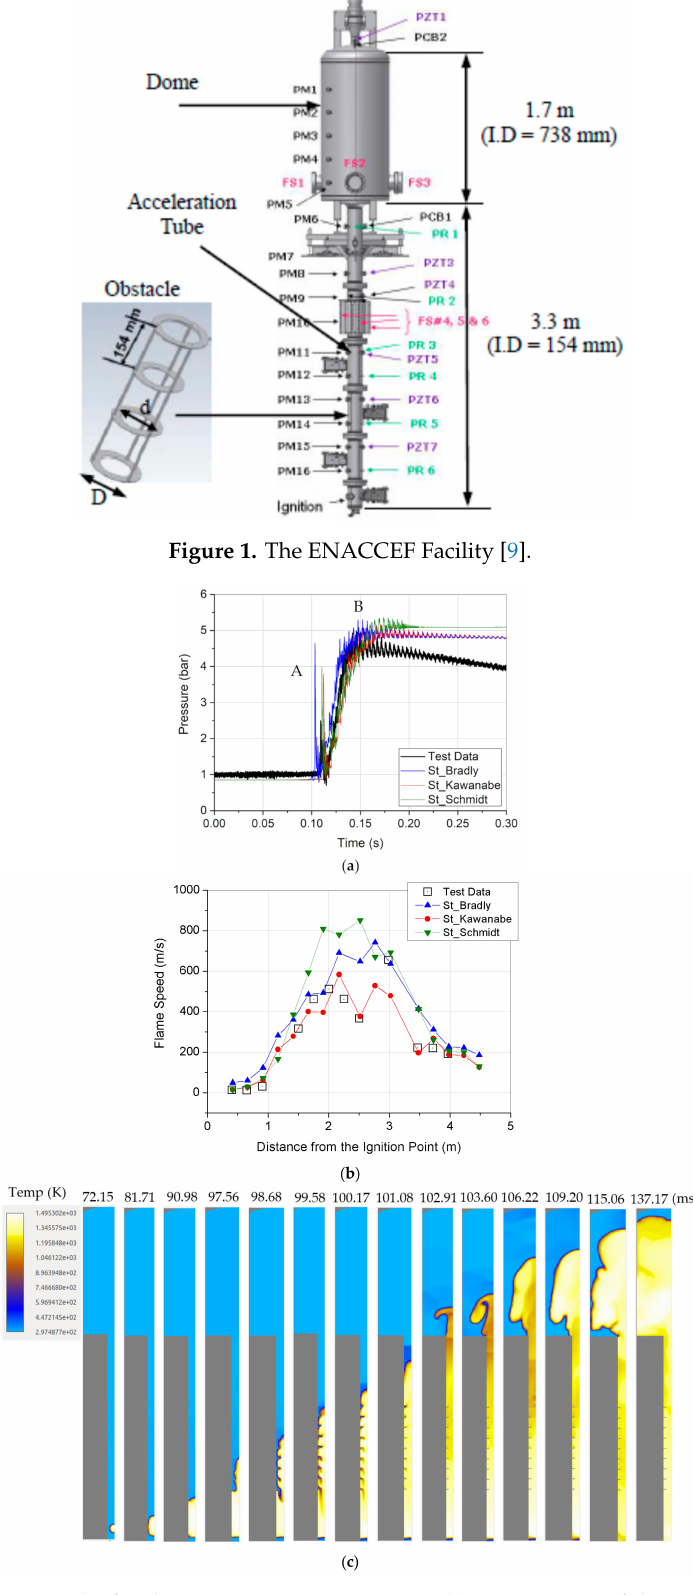
Figure 2. COM3D results for the ENACCEF RUN153 Test. ( a ) Comparison of the pressure behavior between the test data and the COM3D results. ( b ) Comparison of the flame speed between the test data and the COM3D results. ( c ) Calculated gas temperature as time passes (time